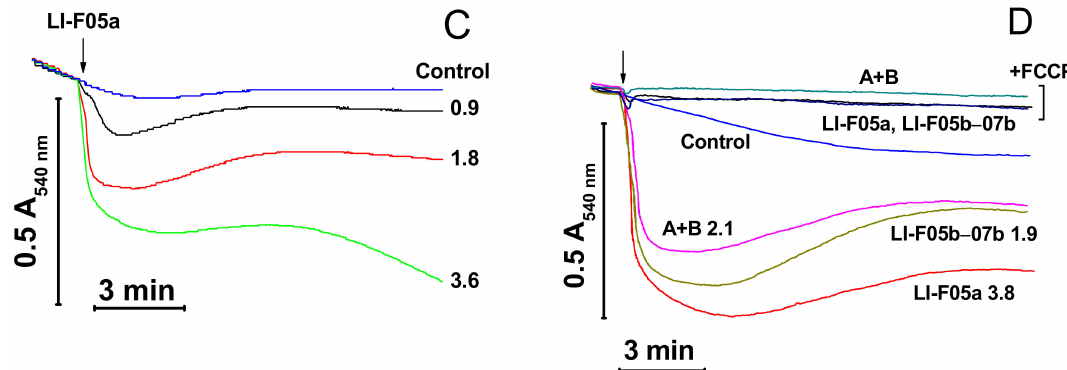
Figure 4. E ff ect of purified FTCs on the swelling of mitochondria with polarized and depolarized inner membranes. Immediately before measurements, mitochondria (0.5 mg protein / mL) were added to KCl-based medium supplemented with 5 mM glutamate, 5 mM malate, 1 mM EGTA, and, where indicated, 500 nM FCCP ( D ). The arrow shows the addition of RS10 ( A ), fusaricidins A + B ( B , D ), LI-F05a ( C , D ), and LI-F05b – LI-F07b ( D ) at indicated concentrations ( µ g / mL) to all samples